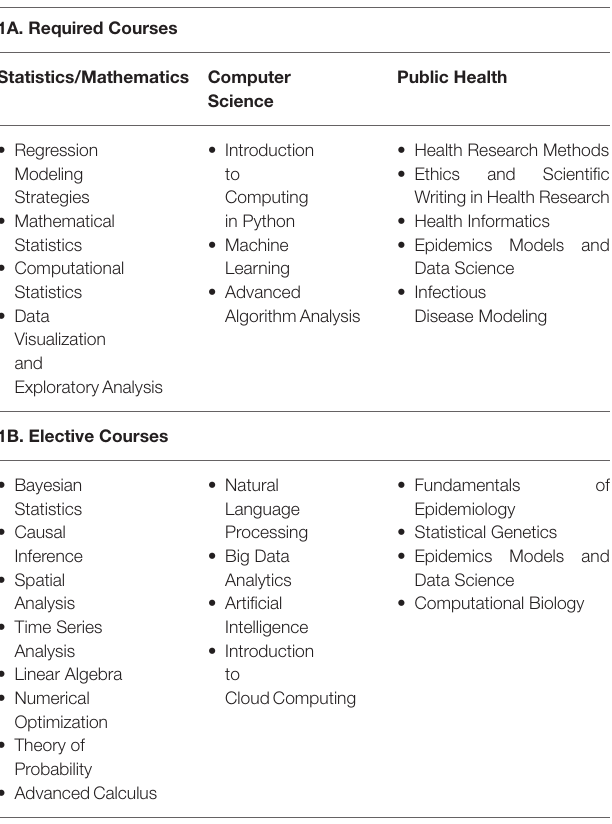
TABLE 1 | Proposed Program for Acquiring Competency in Health Data Science ( 1A. Required Courses; 1B. Elective